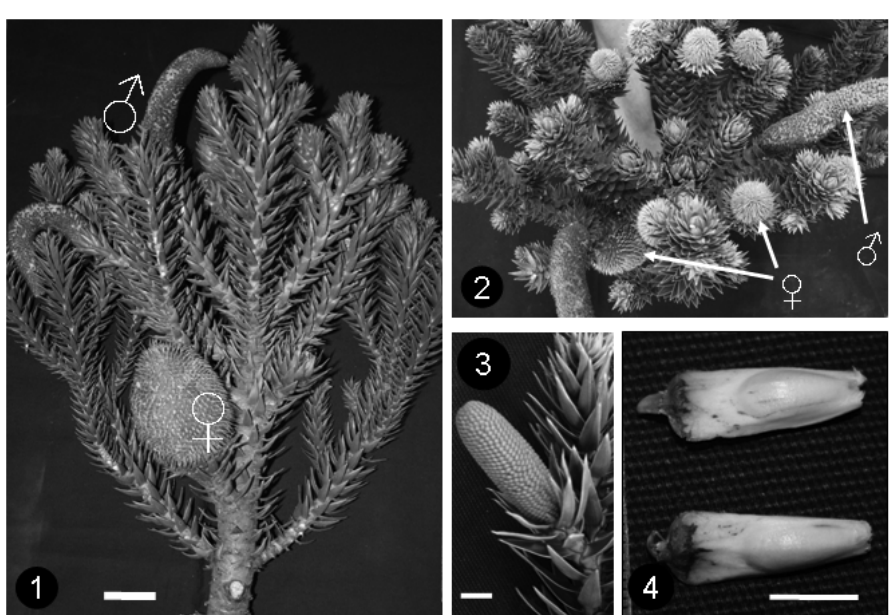
Fig. 1 – Branch showing male and female cones. Note the normal morphological appearance of the reproductive structures. Scale bar = 10 cm. Fig. 2 – Mature male cones and immature female ones, which will maturate in about 18 months. Fig. 3 – Young male cone. Scale bar = 1 cm. Fig. 4 – Seeds of the older female cone present in the collected branch. Scale bar = 1 cm.